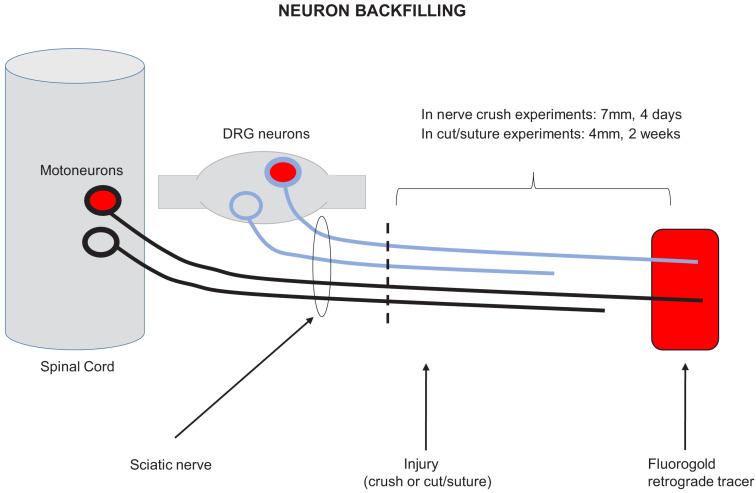
Schematic representation of neuron backfilling.